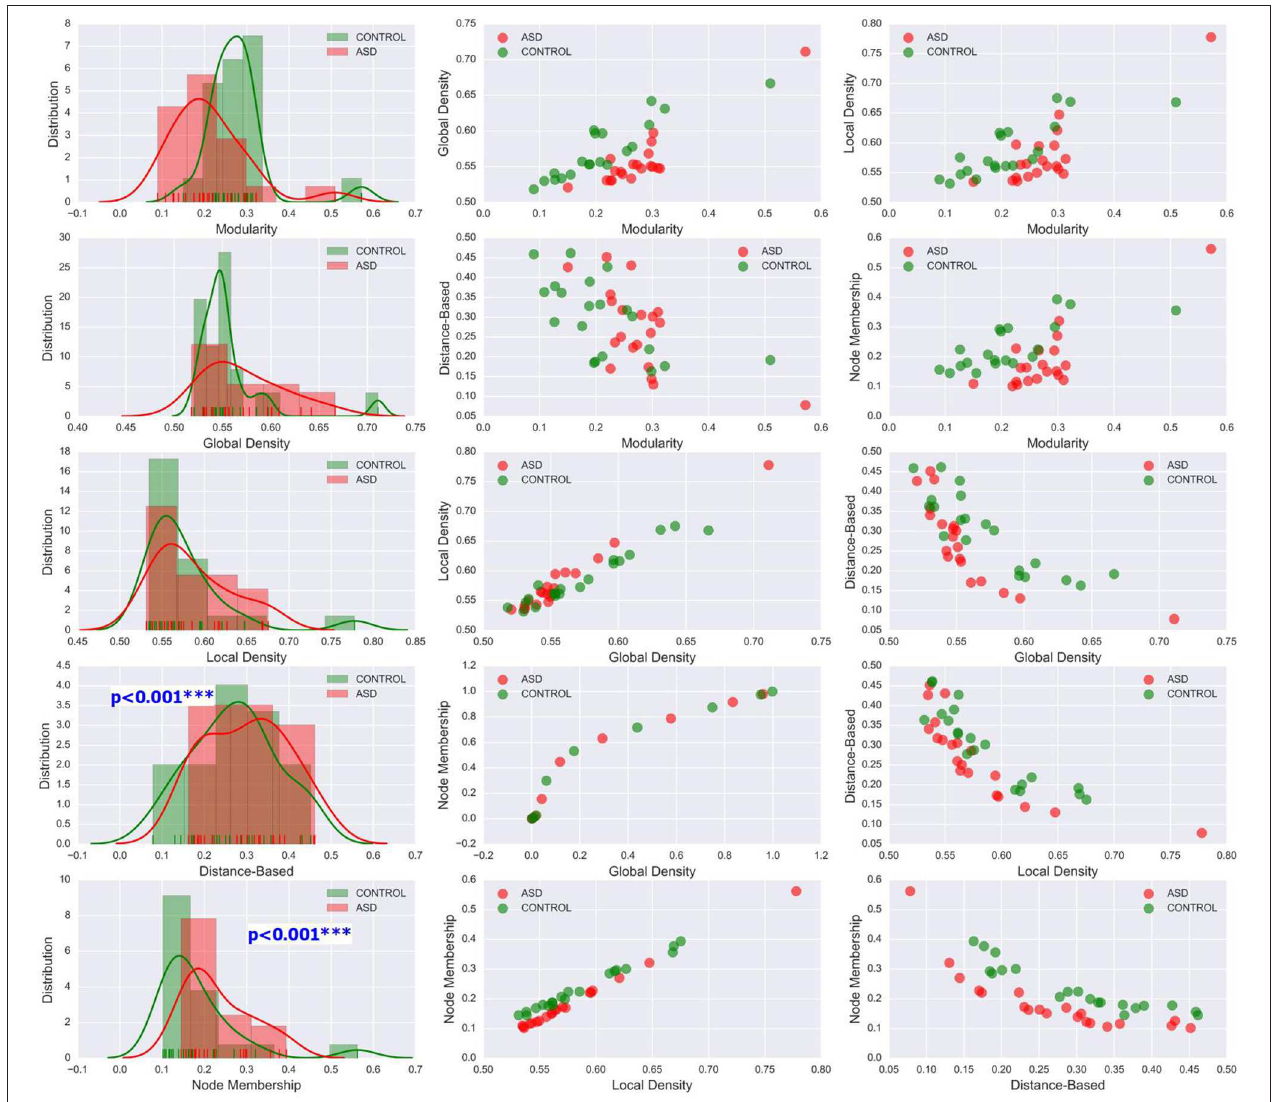
FIGURE 6 | Left column: KDE plots of variations in the five community pattern metrics across subjects and clinical groups in the CAL dataset at threshold T = 0.4 with a Gaussian kernel bandwidth of 0.02. These plots show significant differences in the distribution of community structure metrics between the two groups. Middle and right column: organization of ASD and control group data visualized by scatter plots of all pairs of community pattern